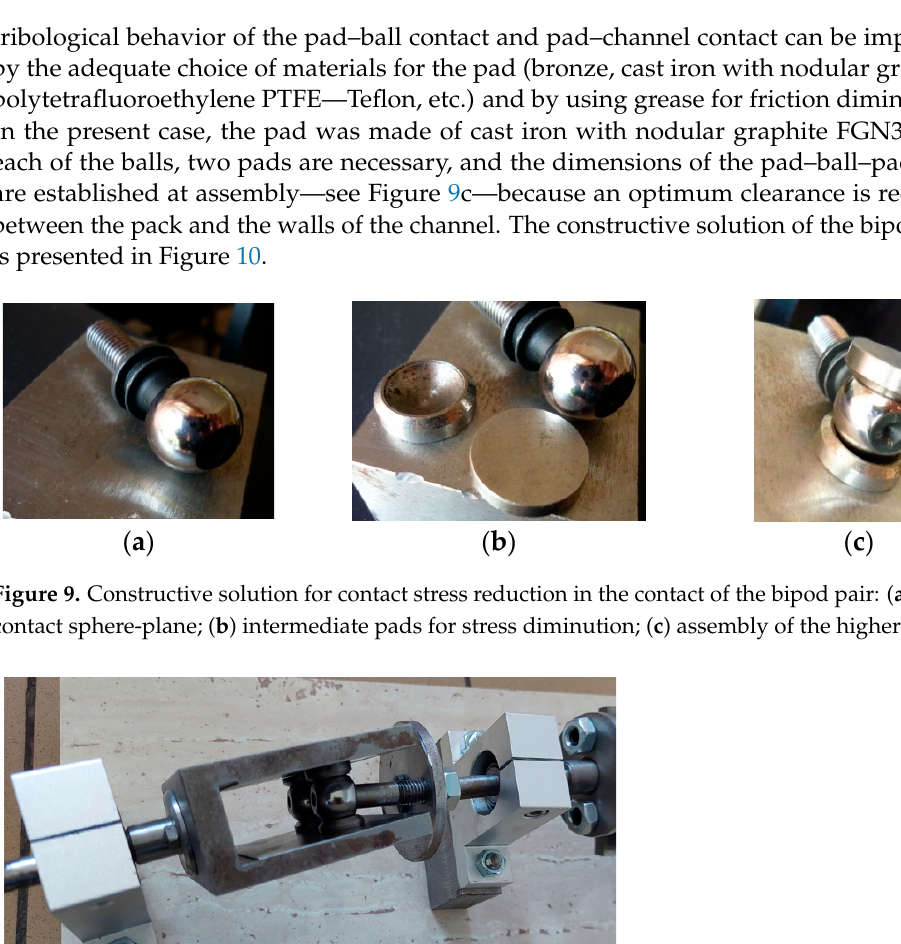
Figure 10. Constructive solution of the bipod pair.